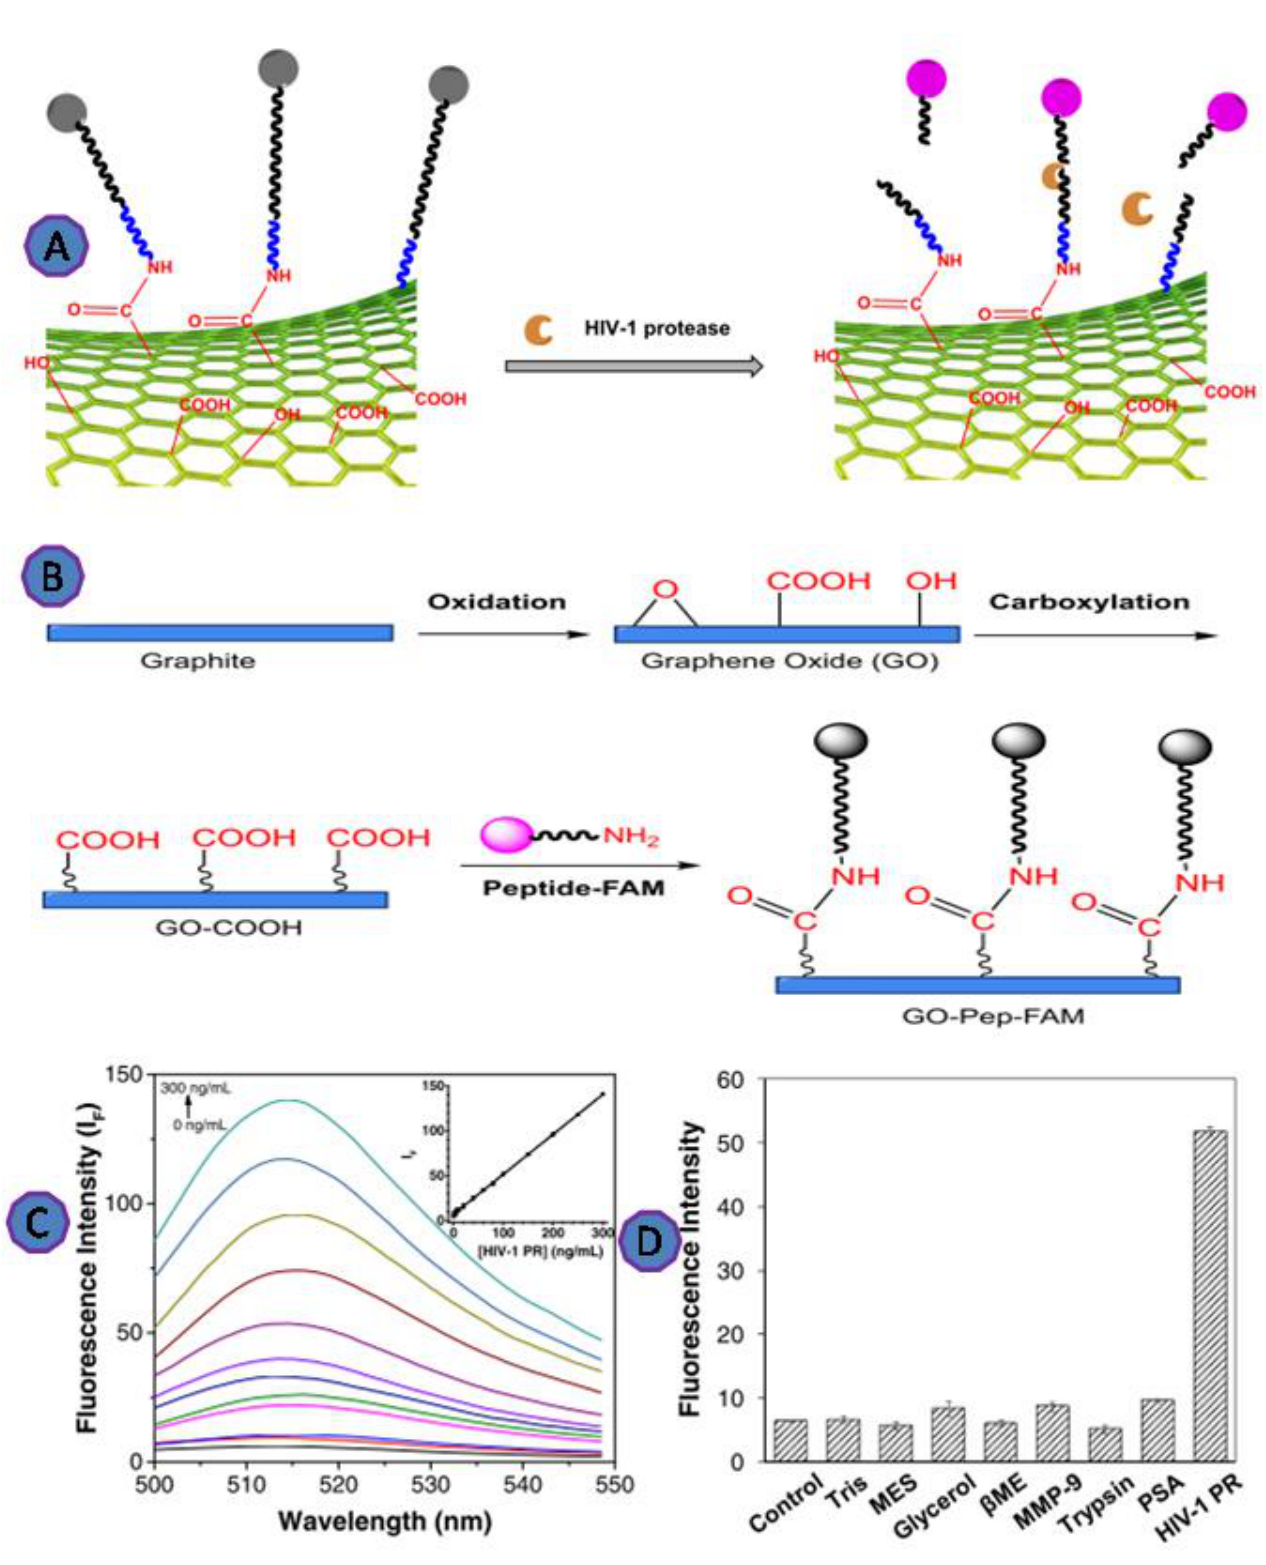
Figure 9. ( A ) Scheme depicting the principles of detecting HIV-1 protease; ( B ) scheme depicting the production of an HIV-1 protease sensor using graphite powder; ( C ) fluorescence spectra of the GO-Pep-FAM sensor in the presence of HIV-1 protease at various doses; ( D ) plot of fluorescence intensity versus various species, demonstrating the selectivity of the GO-Pep-FAM sensor. Reprinted with permission from Ref. [75]. Copyright 2018, Springer Nature.